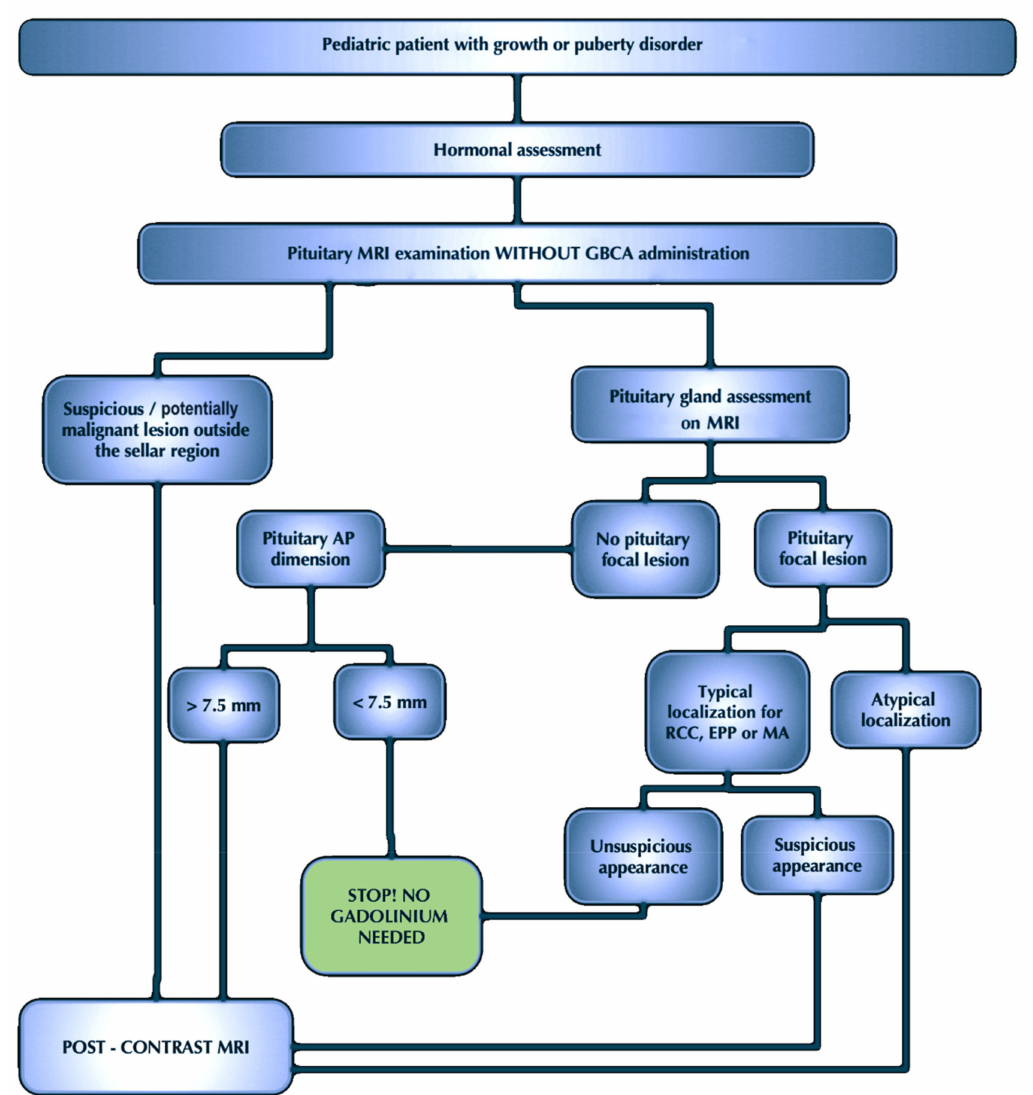
Figure 6. The practical approach for assessment of the pituitary MRI in children with growth or puberty disorders before hormonal therapy. In the new imaging diagnosis algorithm of children with GPDs proposed by us, after endocrinological assessment, patients would have a pituitary MRI examination without GBCA. The results of our study show unequivocally that in most cases, the analysis of native sequences is sufficient to assess the gland to the extent that it allows the patient to qualify for substitution treatment. If the native pituitary MR examination reveals no focal lesion in the parasellar region, and the pituitary AP dimension does not exceed 7.5 mm, the statistical probability of detecting a focal lesion in post-contrast sequences is so small that it is possible to omit gadolinium administration. However, if the AP dimension exceeds 7.5 mm, the examination should be extended by post-contrast sequences. In turn, if a focal lesion in the native MRI is visible, its location and morphology should be carefully assessed. If the lesion location is typical for RCC, EPP, or MA, and the morphology of the focal lesion does not raise suspicions, administration of the contrast agent should also be omitted. However, if the focal lesion has an atypical location, or the location corresponds to RCC, EPP, or MA but its morphology is of concern, in these cases, the pituitary MRI should be extended by post-contrast sequences. Of course, if a suspicious or potentially malignant focal lesion is observed beyond the parasellar region, not only should gadolinium be administered, but the scope of the examination should also be extended, and the entire brain should be